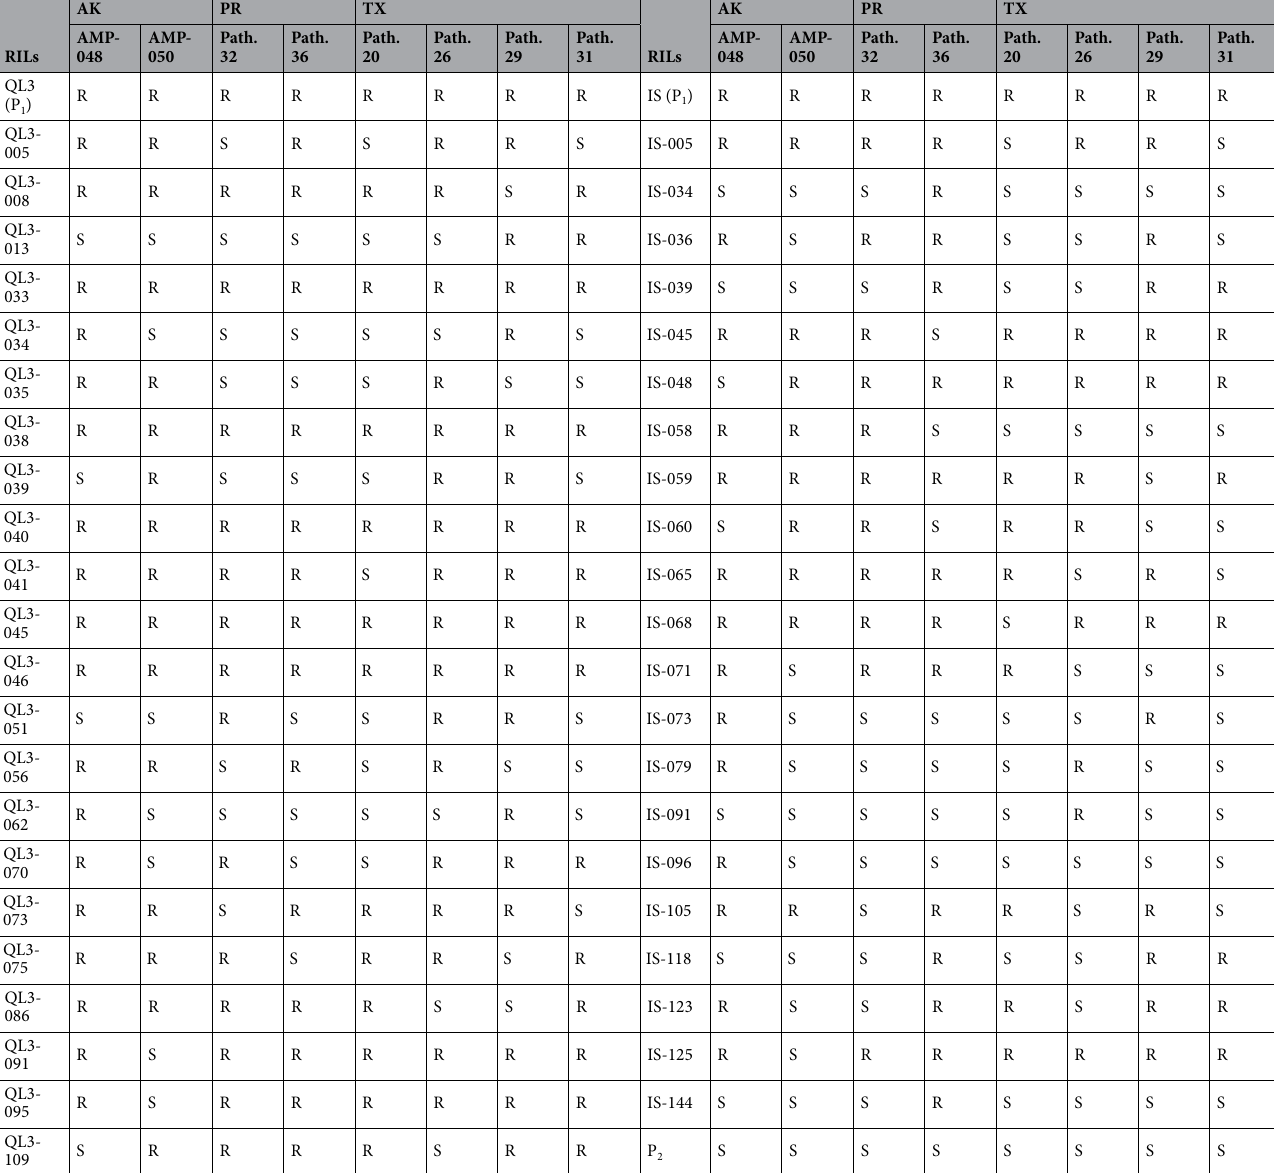
Table 4. Anthracnose resistance response of 43 recombinant inbred lines (RILs) derived from the crosses between QL3 and IS18760 (IS) with a common parental line PI609251 (P 2 ) evaluated against eight pathotypes from Arkansas (AK), Puerto Rico (PR) and Texas (TX), USA. R and S refers to resistant and susceptible, respectively. The C. sublineola pathotypes were based on the classification described by Prom et al. 13,28